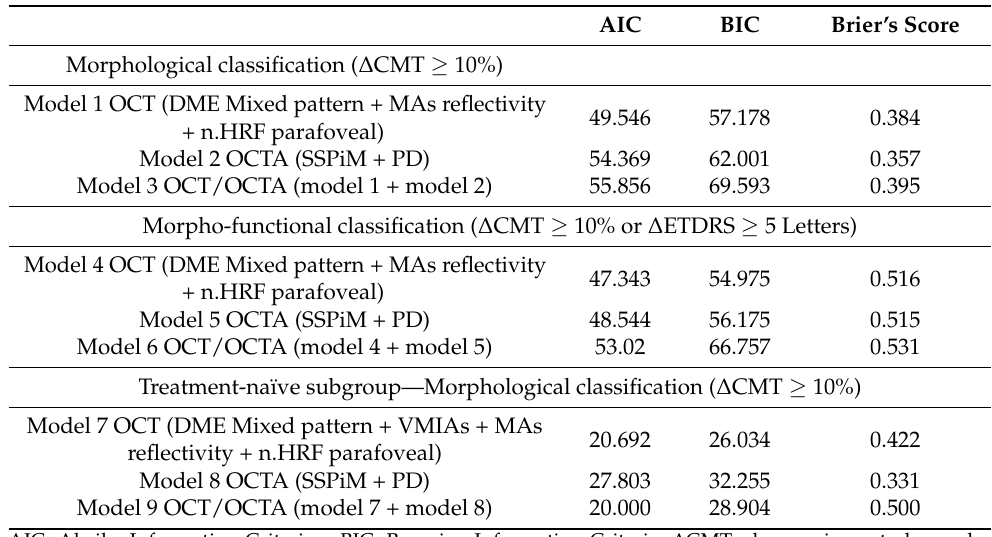
AIC BIC Brier’s Score